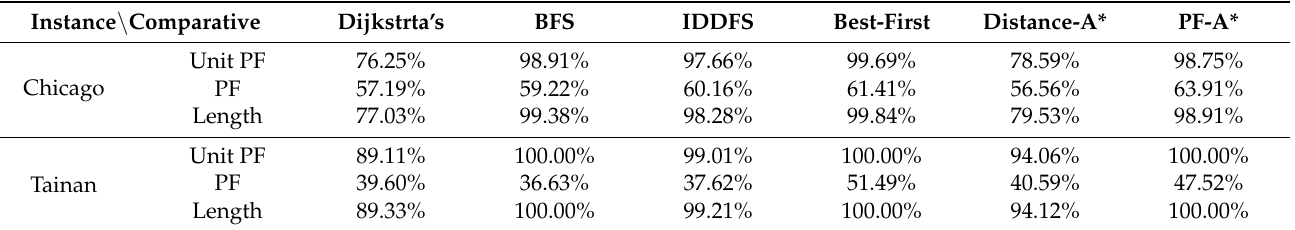
Table 6. Probability for BiasSpan to retrieve a better solution (higher unit PF, higher PF, shorter length) in all test cases compared to other